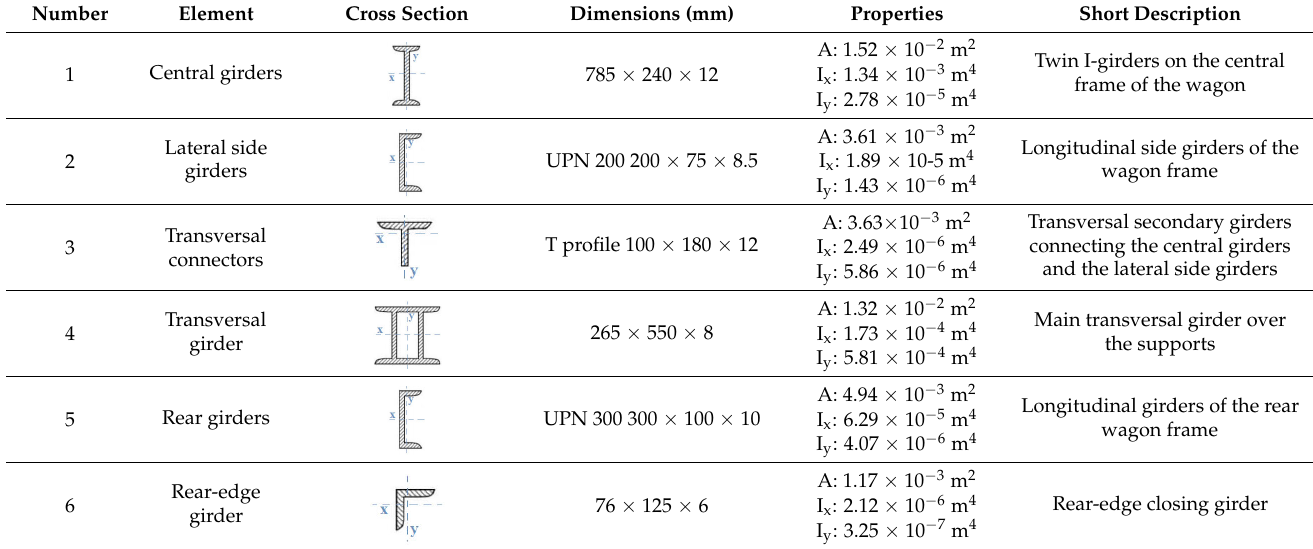
Table 1. Geometrical characteristics of the main elements of the wagon platform. Number Element